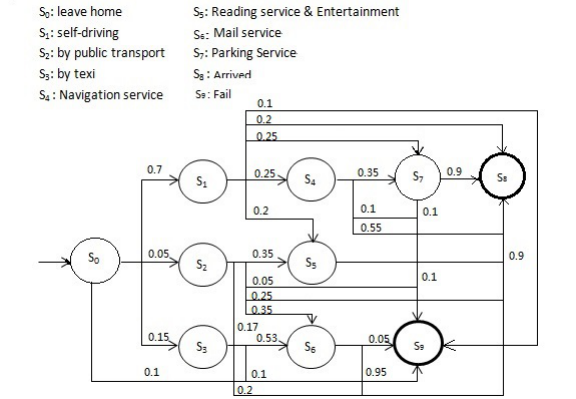
Fig. 5. User’s state